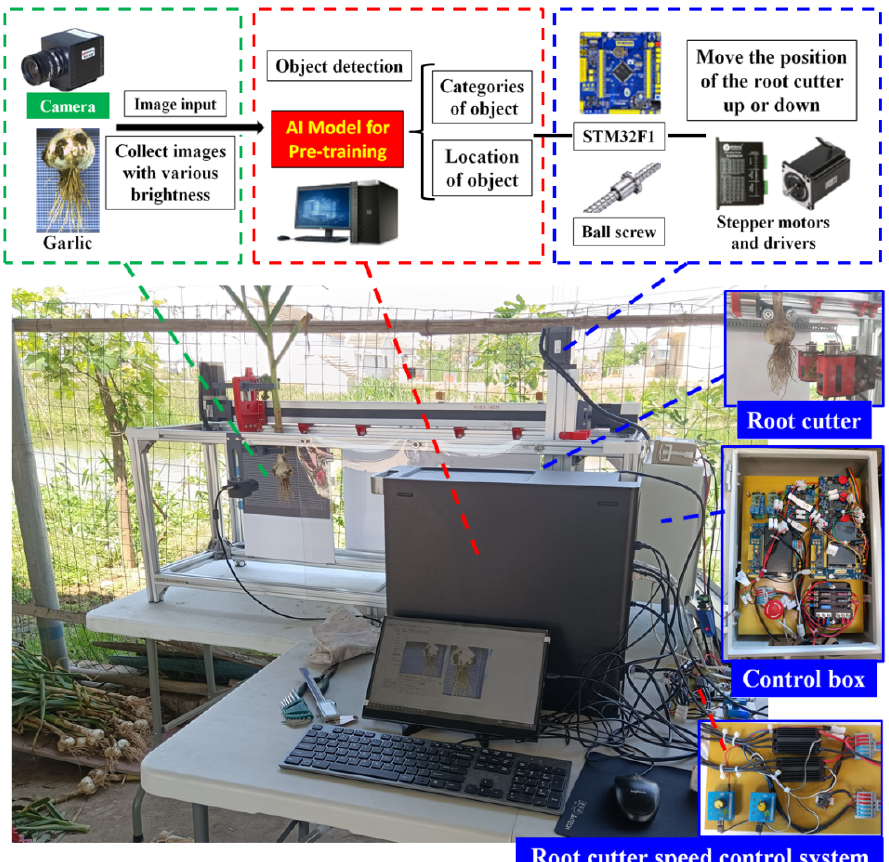
Figure 19. Field test.